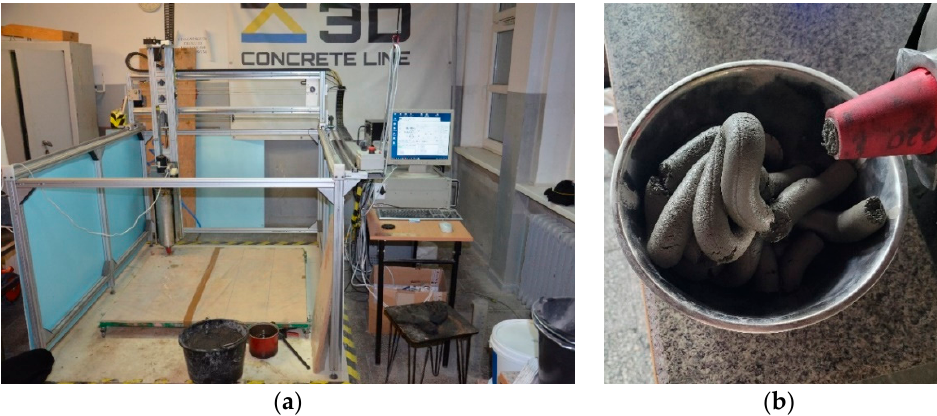
Figure 4. ( a ) Gantry robot with an extruder; ( b ) Mix pumped through the system.